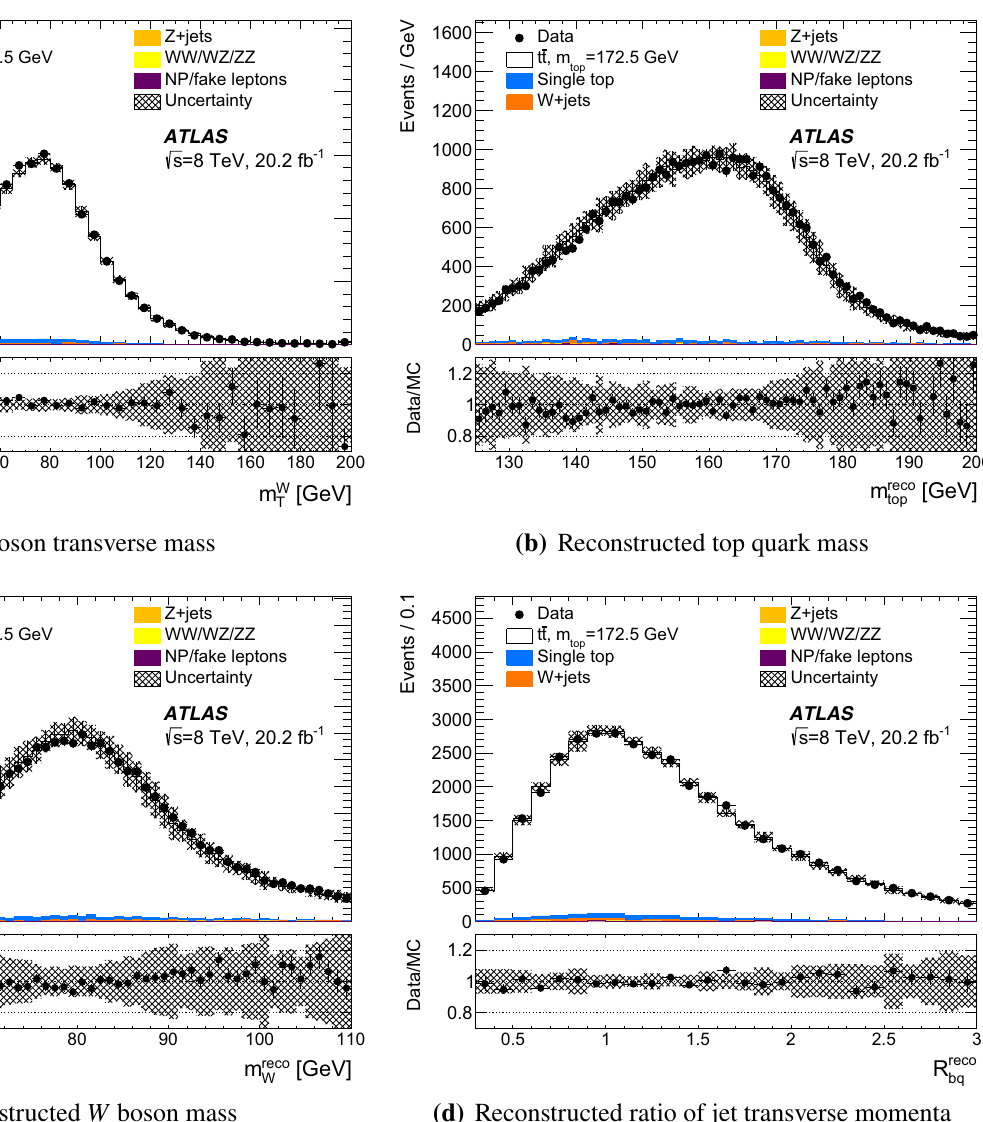
Fig. 4 DistributionsfortheeventspassingtheBDTselection.Thedata areshown,togetherwiththesignal-plus-backgroundpredictionnormal- ized to the number of events observed in the data. The hatched area is the uncertainty in the prediction described in the text. The rightmost bin contains all entries with values above the lower edge of this bin, similarly the leftmost bin contains all entries with values below the upper edge of this bin. a shows the W boson transverse mass for the